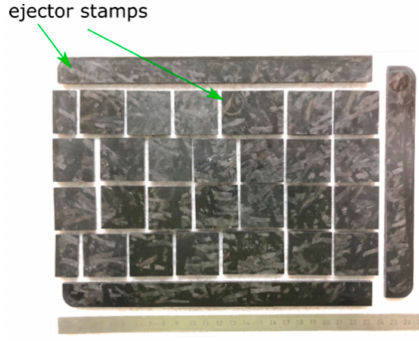
Figure 2. Preparation of SMC specimen out of the molded